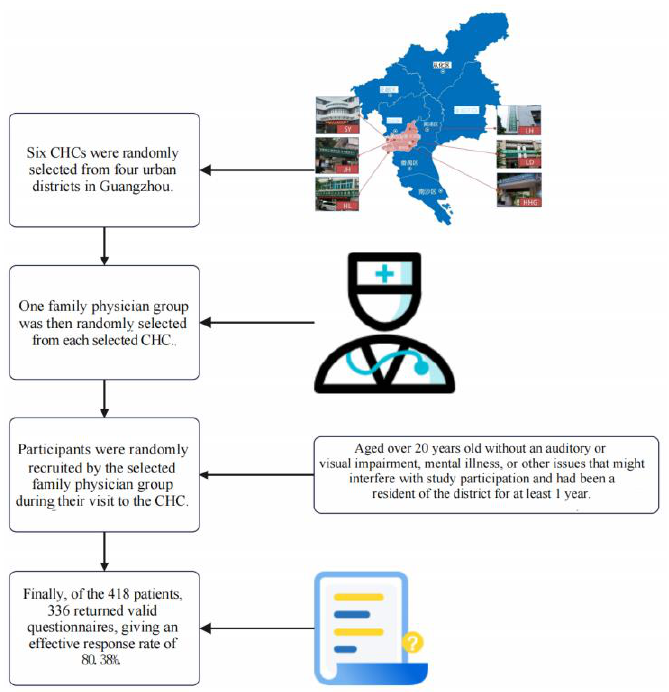
Figure 1. Study flow